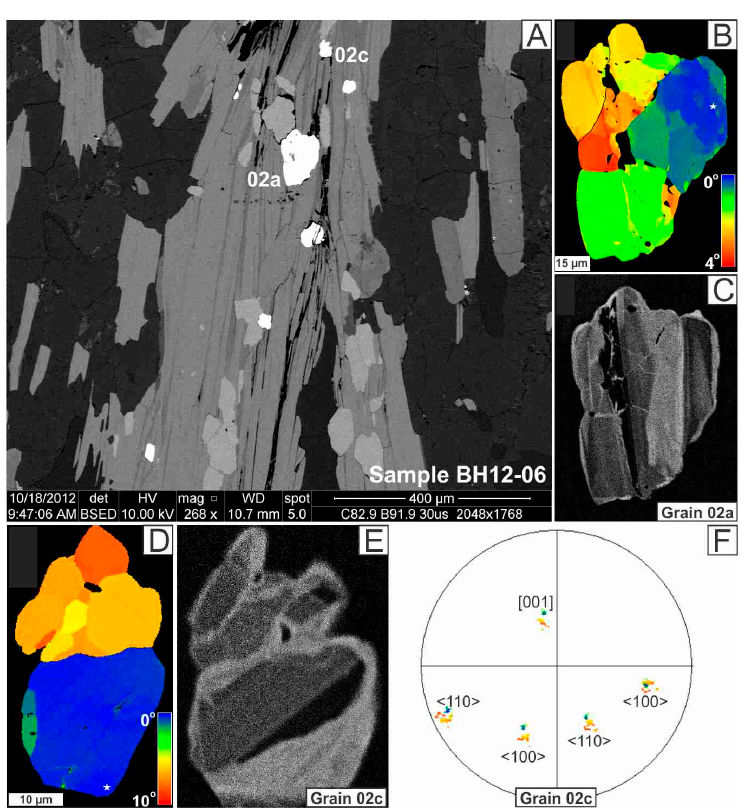
Figure 9. Data on the grain 02a and 02c, sample BH12-06. ( A ) BSE image showing the petrological context of the deformed zircon grains. ( B ) Cumulative misorientation or texture component EBSD map of the grain 02a, showing the orientation of every data point with respect to a user-selected reference point (white star). Misorientation varies from 0 (blue) to 4° (red). ( C ) Panchromatic CL image of the grain 02a. ( D ) Cumulative misorientation EBSD map of the grain 02c, showing the orientation of every data point with respect to a user-selected reference point (white star). Misorientation varies from 0 (blue) to 10° (red). ( E ) Panchromatic CL image of the grain 02c. ( F ) Lower hemisphere equal area projection pole figure for the grain 02c, showing unsystematic dispersion of